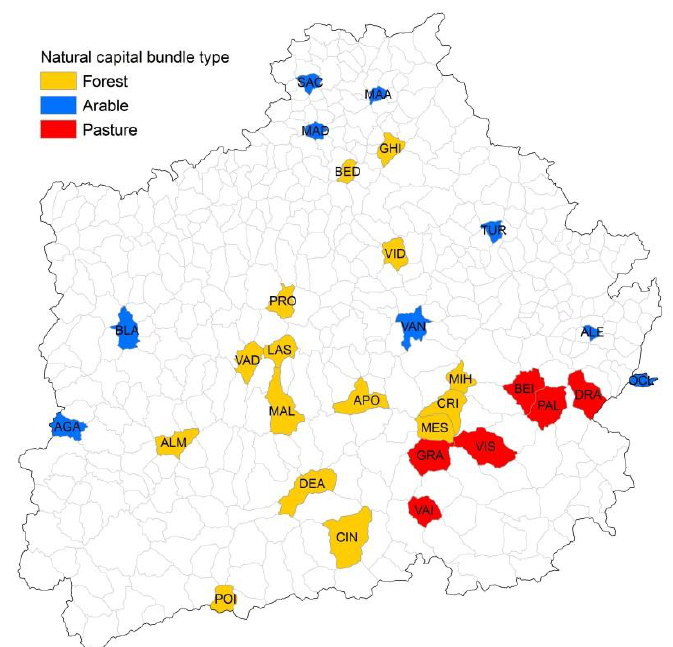
Appendix Fig. A1.2. Statistical classification of the 30 focal villages according to their natural capital assets. The three village types (forest – yellow, arable - blue, pasture - red) were derived from agglomerative cluster analysis (see Fig.